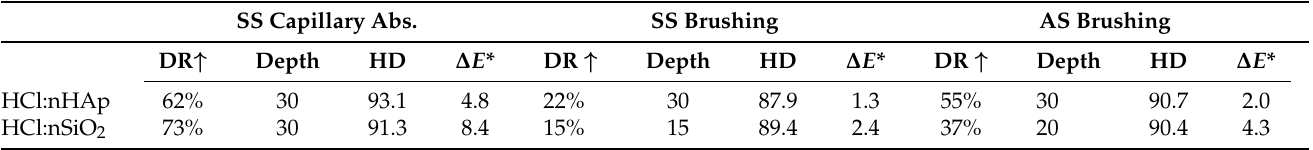
Table 7. Summary of the parameters assessed for sound stone (SS) and aged stone (AS) samples treated with HCl:nHAp and HCl:nSiO 2 by capillary suction and brushing. Legend: DR ↑ —drilling resistance increment; Depth—maximum penetration depth (in mm) observed through DR measure- ments; HD—Shore hardness D; ∆ E *—total colour variation. SS Capillary